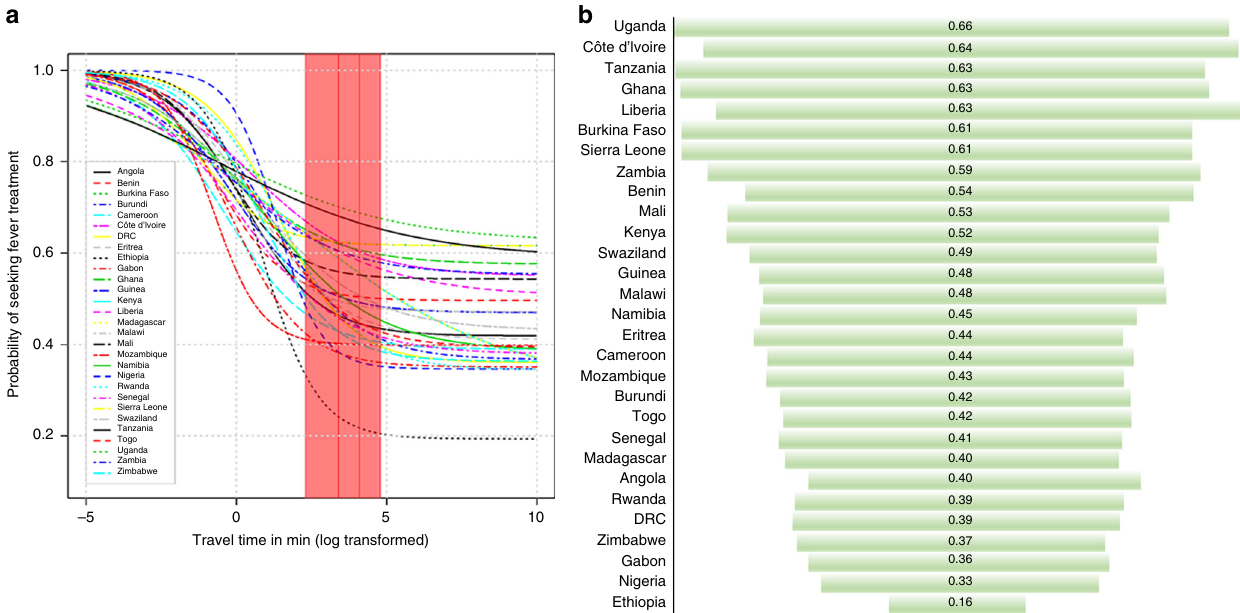
Fig. 3 Probability of seeking fever treatment. a National variation in the probability of seeking fever treatment (posterior median) for any type of public health facility. The red shaded region and vertical lines represent the probability of seeking treatment for fever in the public sector by travel time at 10 min, 30 min, 1 h and 2 h. b Funnel plot representing national posterior median probability of seeking fever treatment in the public sector (length of bar indicates the probability) at 2 h ’ travel time to the nearest primary healthcare facility (dispensary, clinic or health post). The probability of treatment was modelled based on the item response theory (IRT) fever, our fi ndings show national and sub-national variation in the probability of seeking treatment for fever in the public sector.